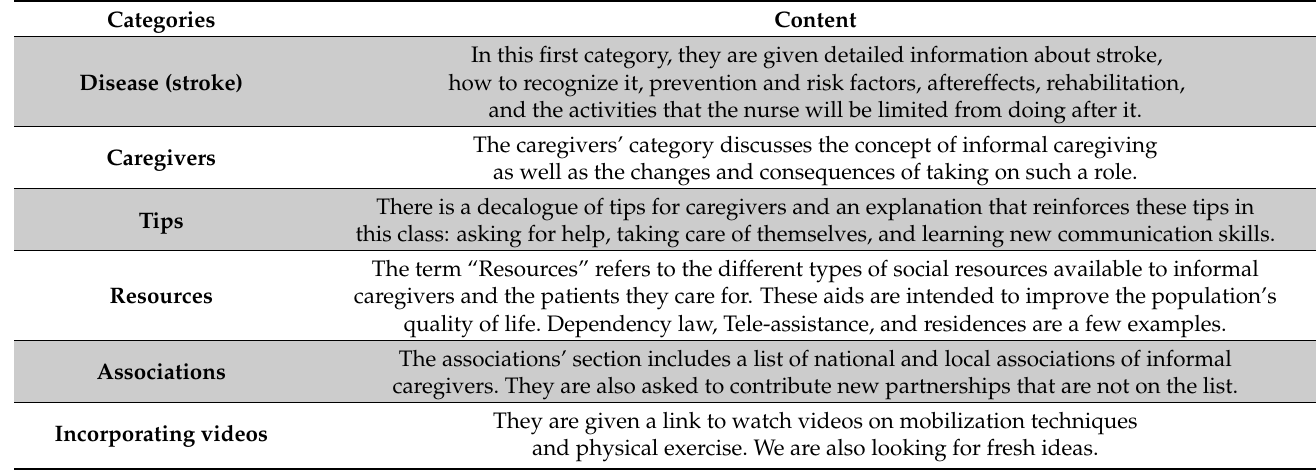
Table 1. The content prepared by the researchers and offered to the experts in the first round.